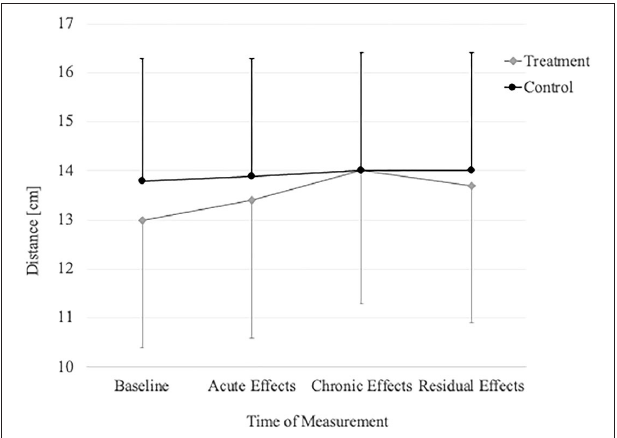
FIGURE 4 | Change in WBLT over time in the treatment group and controls. of ROM improvements following foam rolling interventions